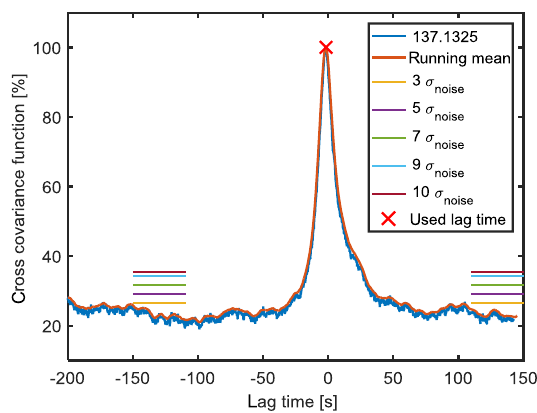
Figure 2. For each compound which had a maximum above 3 σ noise , the deviation of the CCF maxima from zero was used as the lag time